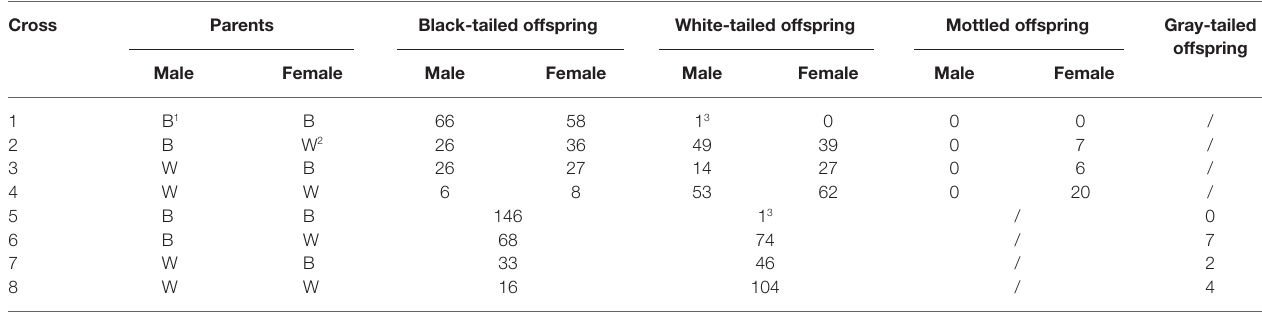
TABLE 1 | Progeny phenotypes of eight crosses in the Dwarf chicken population. Cross